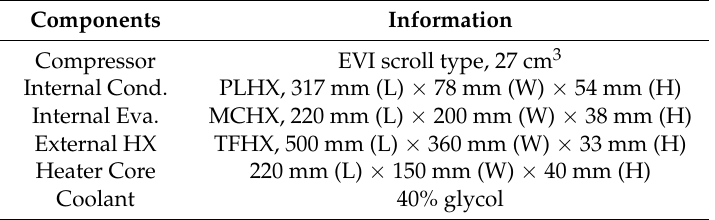
Table 1. System components information. PLHX, plate heat exchanger; MCHX, microchannel heat exchanger; TFHX, tube and fin heat